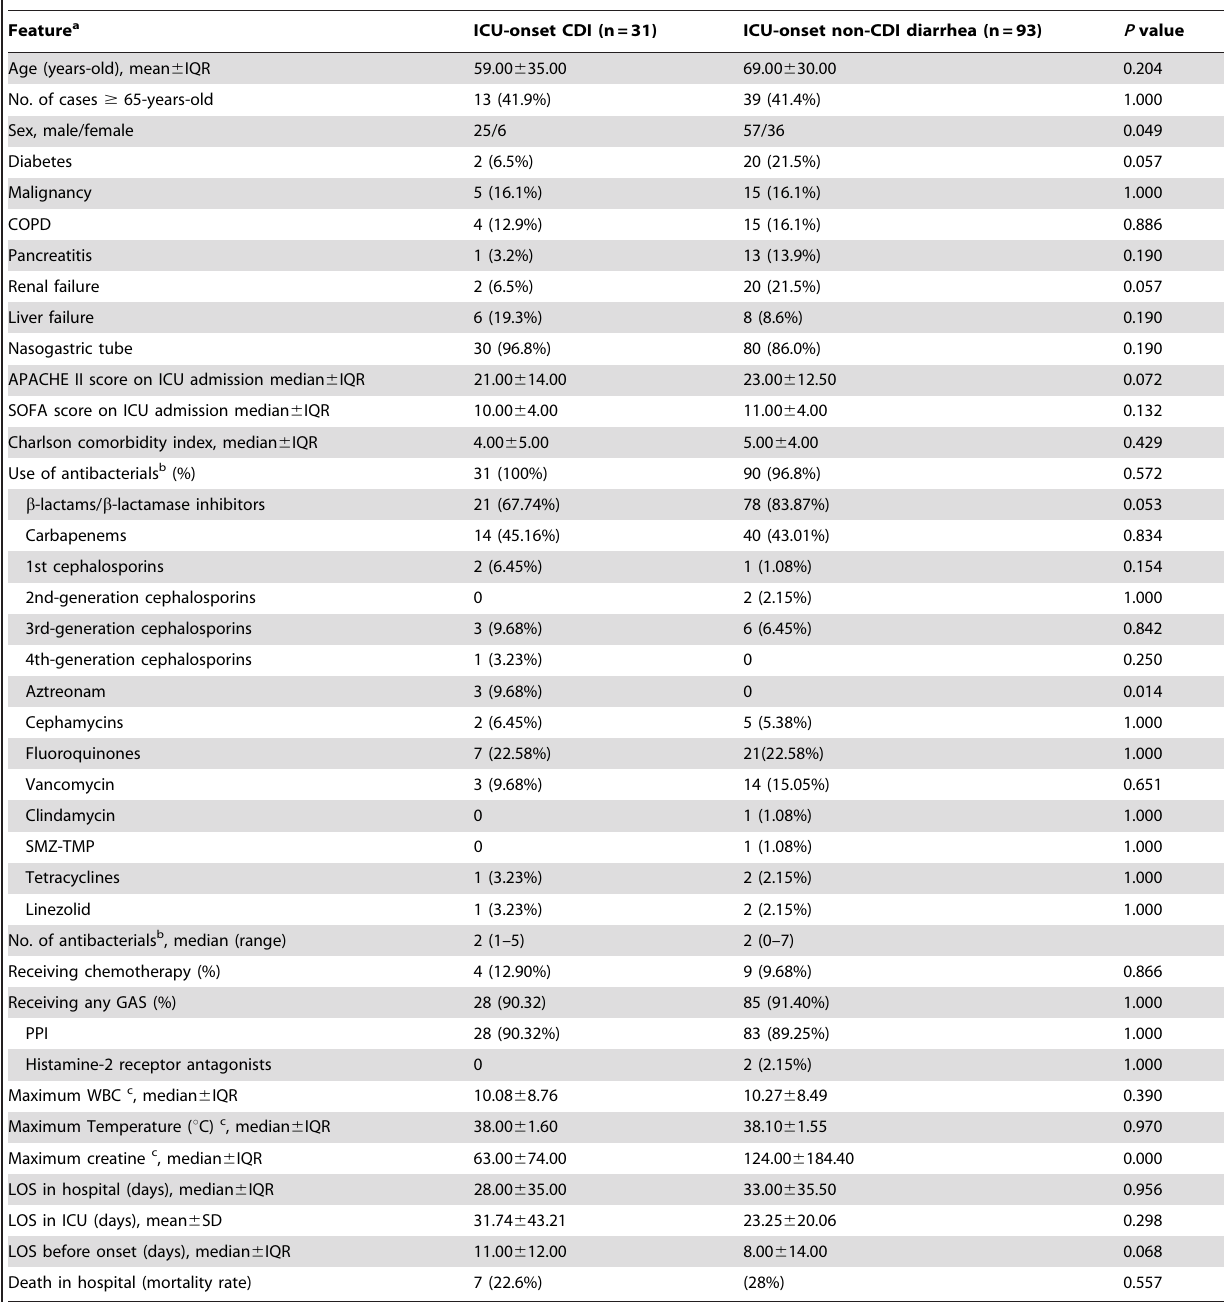
Table 1. Features and outcomes of ICU-onset CDI and non-CDI